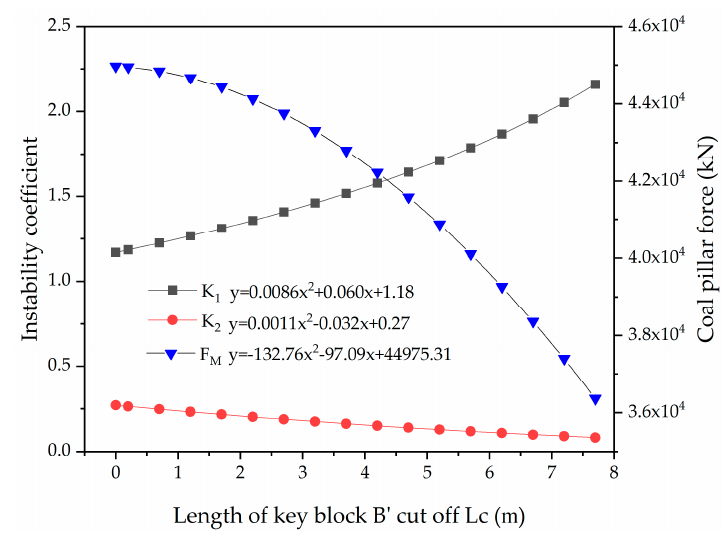
Figure 8. The functional curves of K 1 , K 2 , and F M with respect to Lc.